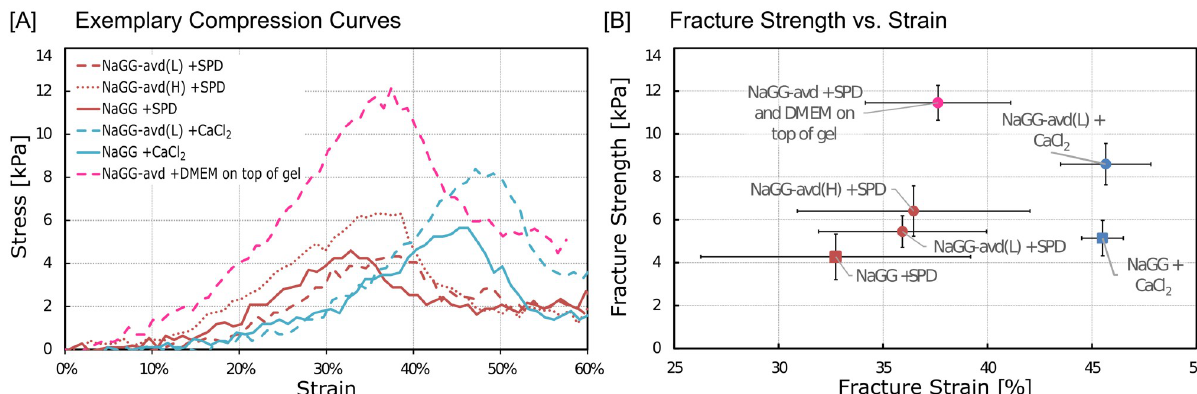
Fig 4. Compression testing results. (A) Representative compression curves of samples with different composition. (B) plot of fracture strength against fracture strain When examining all data, fracture strength (p = 9.28 x10 -11 ) and fracture strain (p = 1.4 x10 -4 ) are statistically different. Testing within samples formed with SPD, however, no significant difference is observed between fracture strength (p = 0.06) and fracture strain (p = 0.54). Error bars represent one standard deviation calculated from five independent